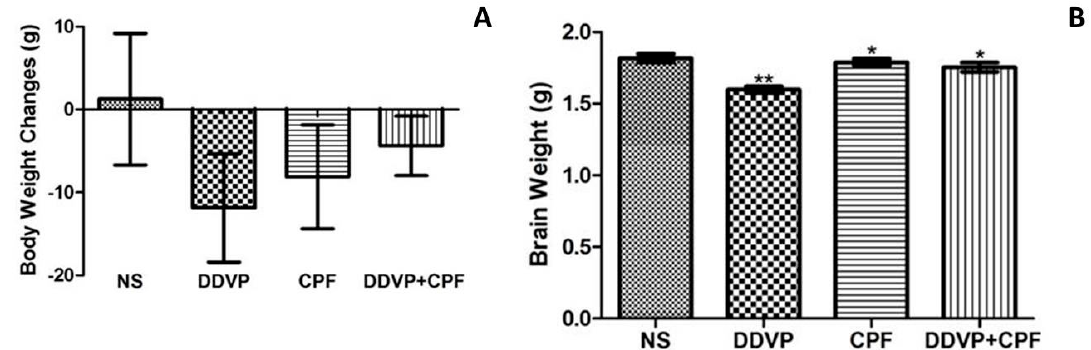
Figure 1. Exposures to dichlorvos (DDVP) and chlorpyrifos (CPF) results in loss of body and brain weight ( A ) Body weight of control and exposed/treated rats ( B ) Brain weight of control and exposed/treated rats. Double asterisks (**) indicate a significant ( p ≤ 0.05) reduction when compared with all groups, while a single asterisk (*) indicates a significant ( p ≤ 0.05) when compared with normal saline (NS). One-way analysis of variance (ANOVA) with a post hoc Bonferroni’s multiple comparison test.